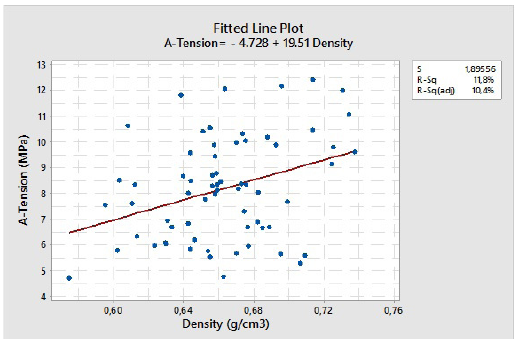
Figure 15. Plotting of the results for the 45-A Orientation Tension Strength and Density.